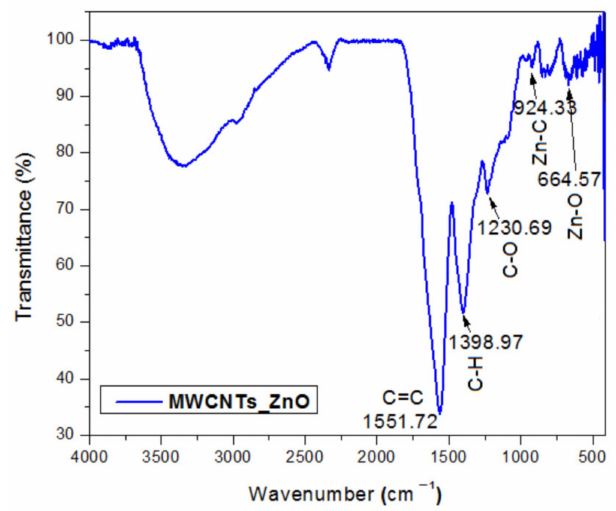
Figure 1. FTIR spectra of the